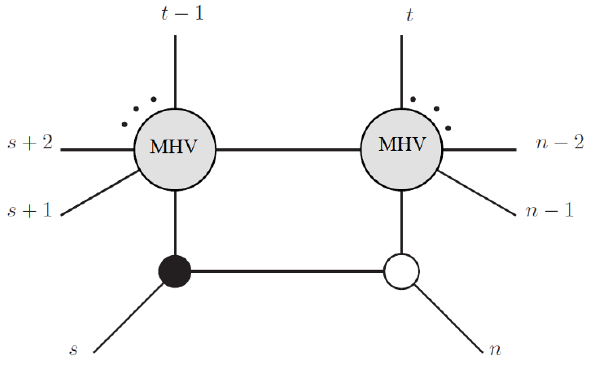
Figure 3 . Diagram arising at the second ( s = 2) recursion step (the missing ends 1 : : : s (cid:0) 1 are added with the